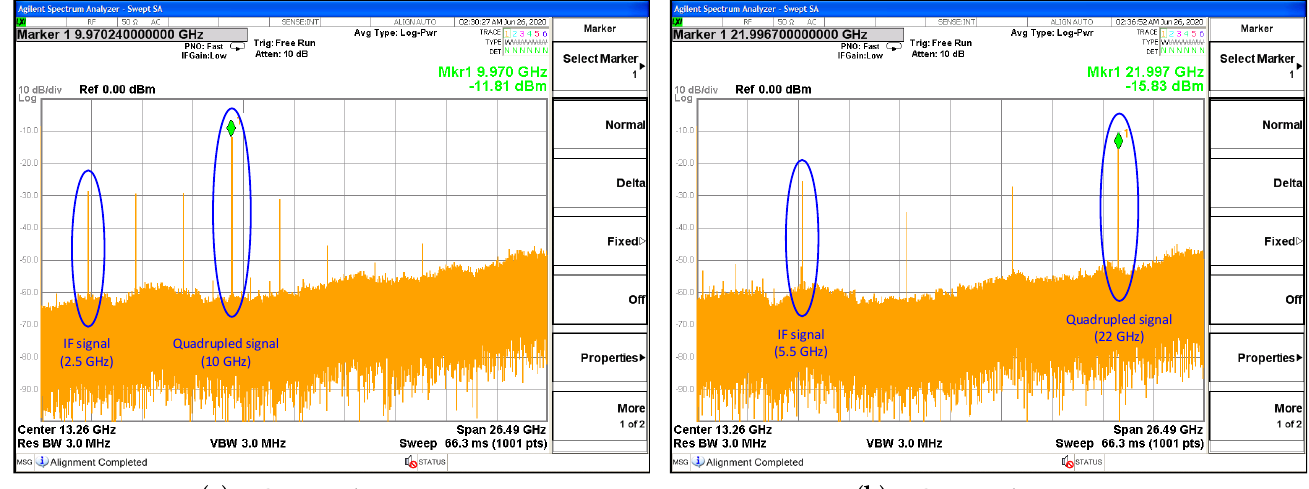
Figure 6. The generated signal of the DPMZM by the proposed automatic bias technique. ( a ) The signal with a frequency of 10 GHz generated based on the intermediate frequency (IF) signal with a frequency of 2.5 GHz. ( b ) The signal with a frequency of 22 GHz generated based on the IF signal with a frequency of 5.5 GHz.